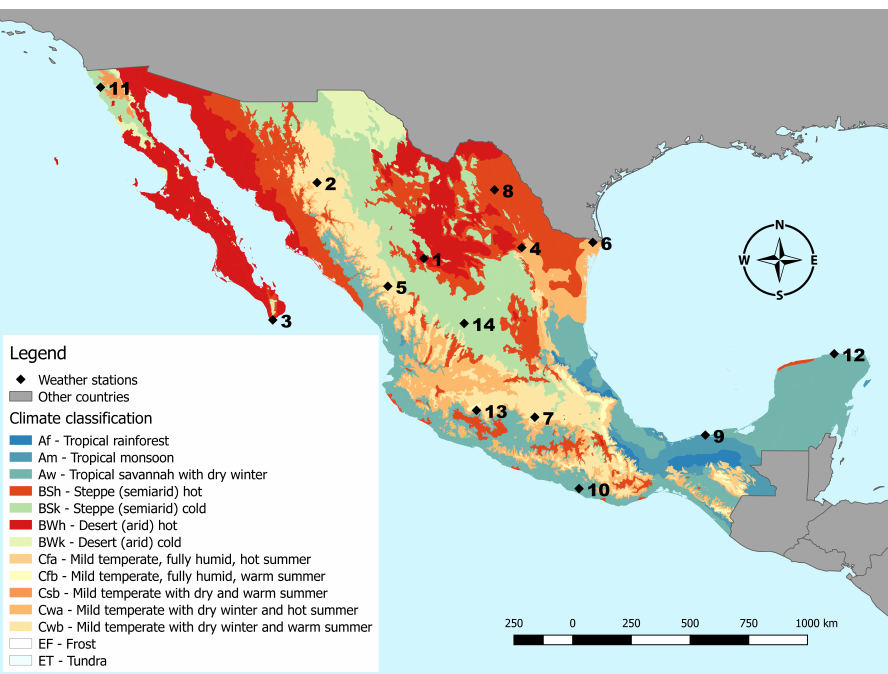
Figure 1. Study sites and types of climate in Mexico.